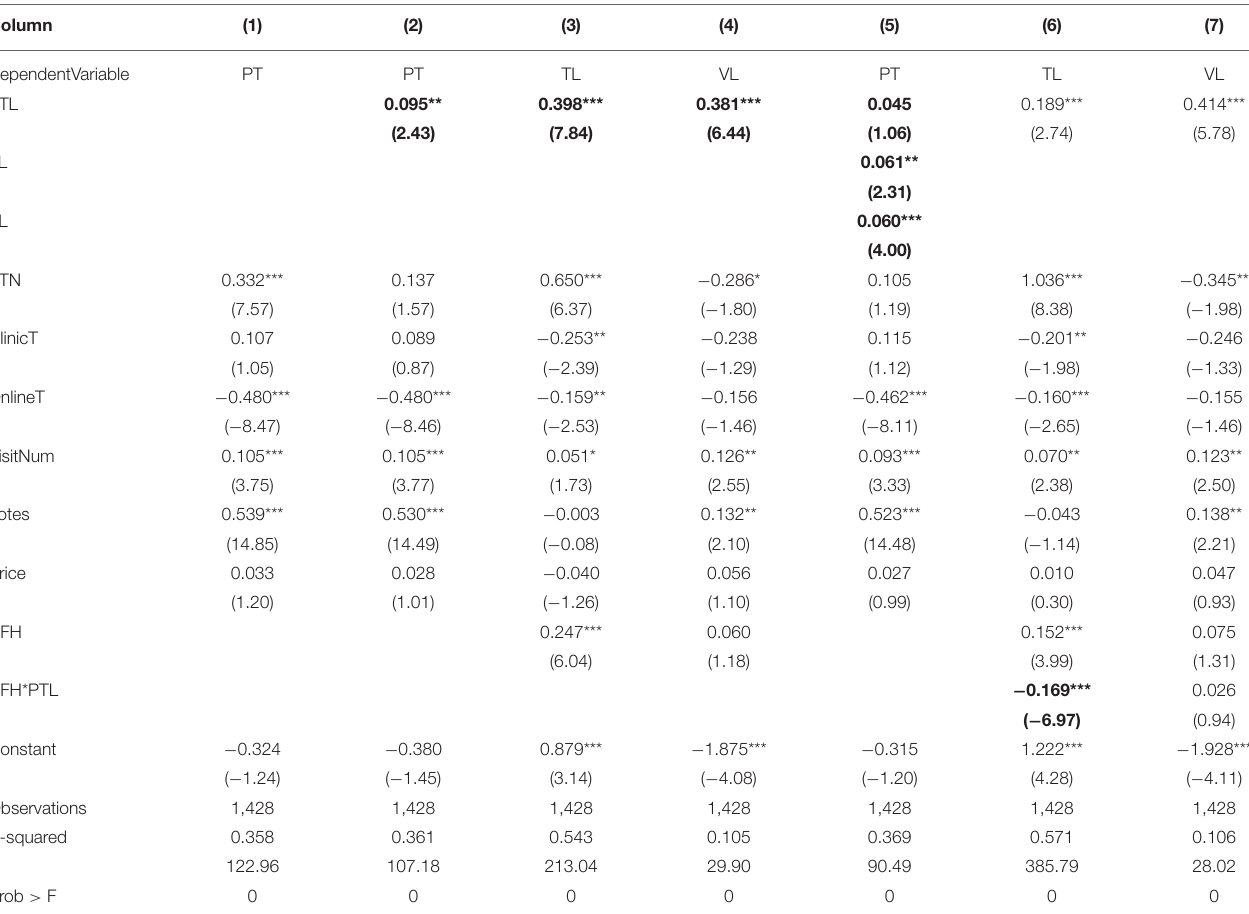
TABLE 6 | Robustness